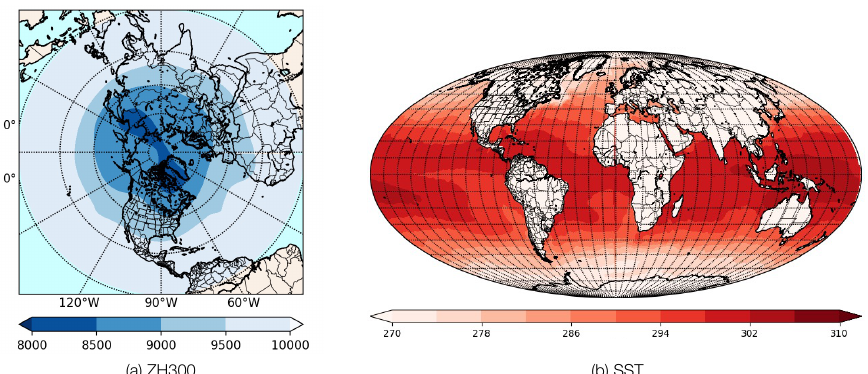
Figure 4. A sample of the monthly spatial plot of January 2018. ( a ) The Northern Hemisphere of ZH300 data, where deep blue represents the lower value of ZH300. ( b ) The entire globe in the spatial grid of SST data, where deep red represents high temperature, and the terrain area (white) is ignored. Note that these projections are just for